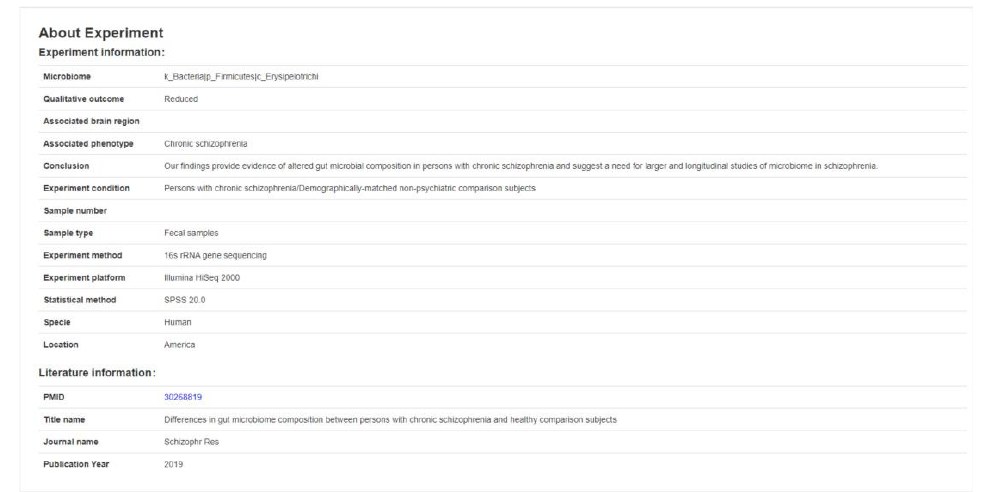
Figure 5. Display page of the content list regarding the brain and gut microbiome search interface. Users can search and read all the data collected in this section; experimental information and literature information of each record for reference is also